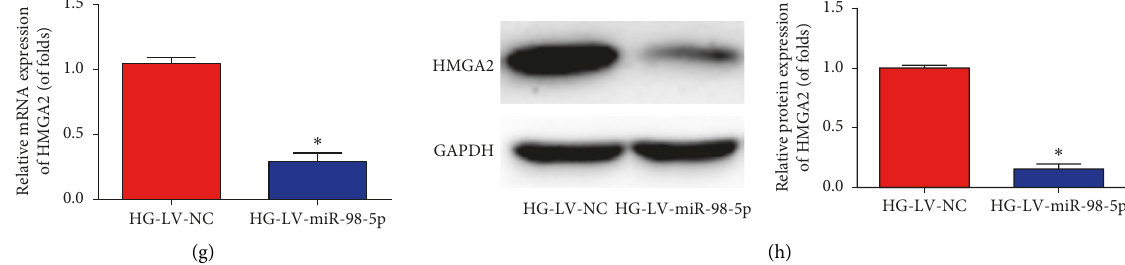
SD of at least triplicate ±